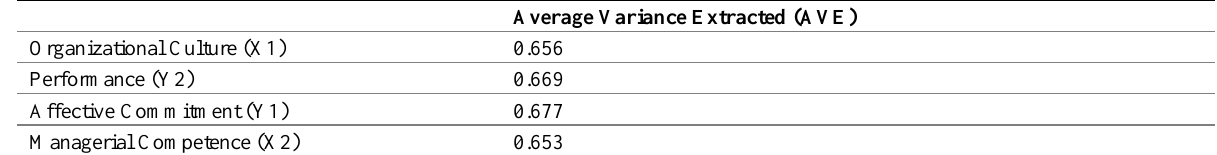
Table 14: Average Variance Extracted (AVE) Value